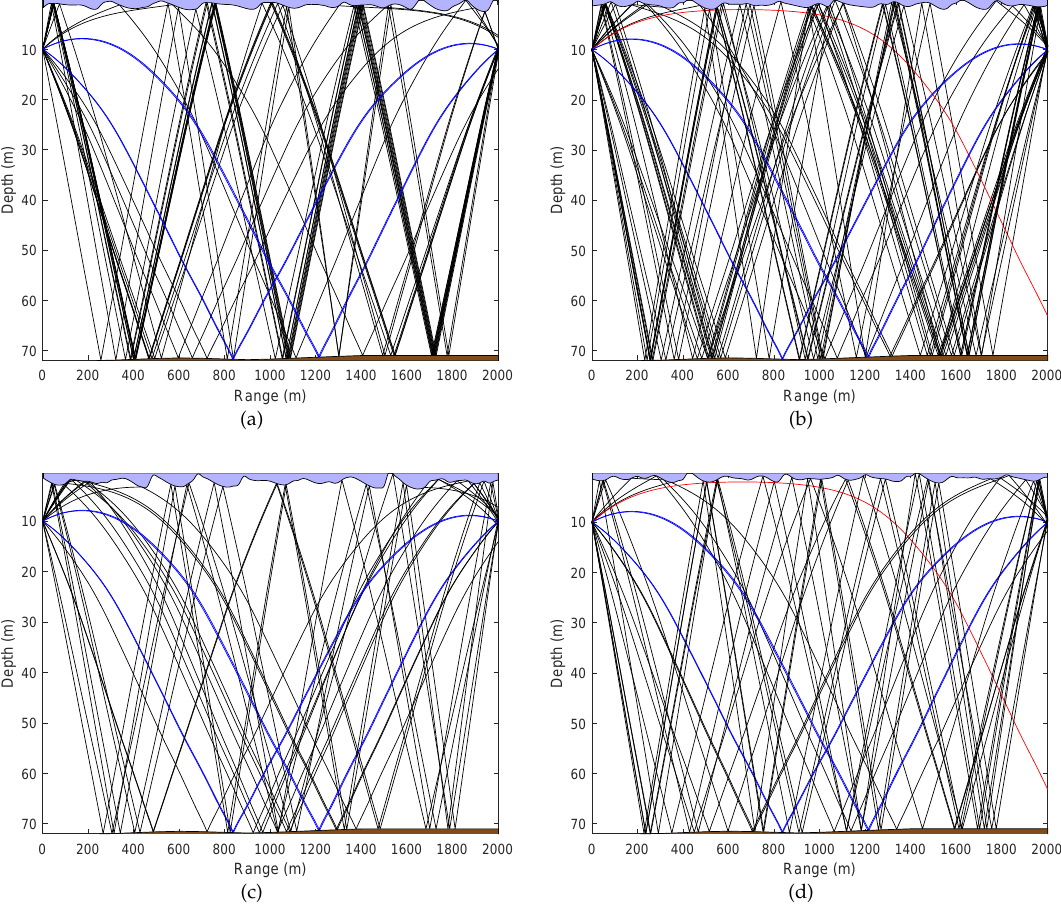
Figure 12. Eigenrays of channel with different sea surface boundaries. The color of lines indicates whether eigenrays hit surface boundary or bottom boundary of the sea. Sea surface boundaries of each figure: ( a ) Sea Surface 1; ( b ) Sea Surface 2; ( c ) Sea Surface 3; ( d ) Sea Surface 4.